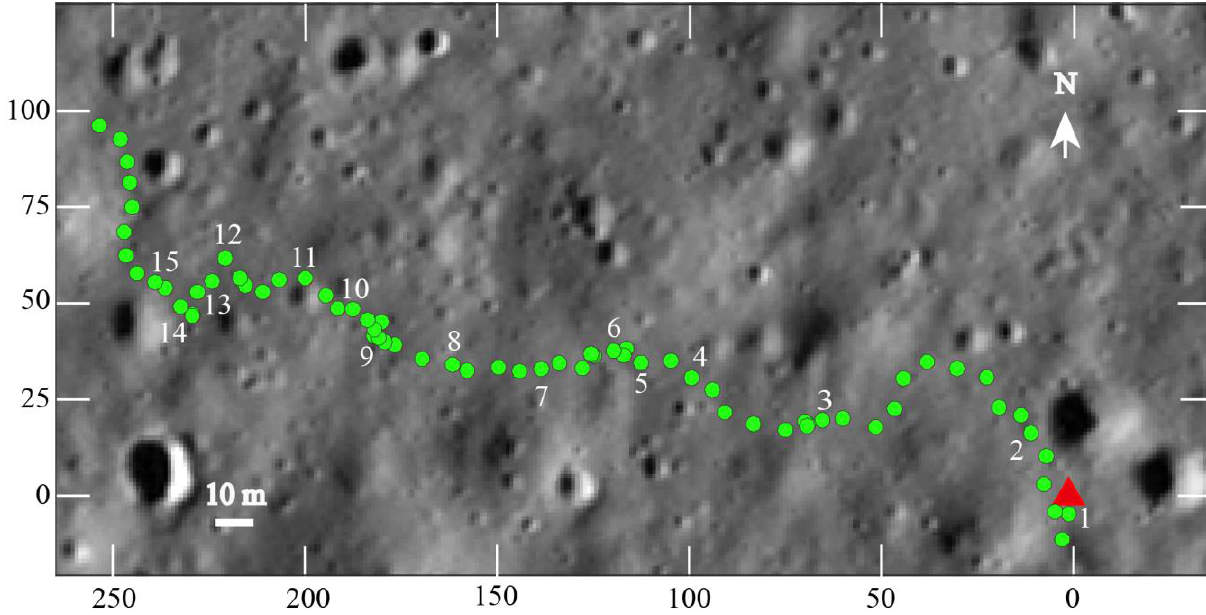
Figure 2. Motion path of the Yutu-2 rover during the first fifteen lunar days. Background image is the LROC (Robinson et al., 2010) Narrow-Angle Camera (NAC) image of the Yutu-2 rover’s surveying area (NAC image ID: M134022629LE, 1.27m/pixel, 77.55° incidence angle) [4]. The white arrow indicates north. The landing site of the Chang'e-4 mission is marked by a red triangle and the waypoints of the rover’s path are marked as green dots. The number near the waypoint is the starting position of the corresponding lunar day.